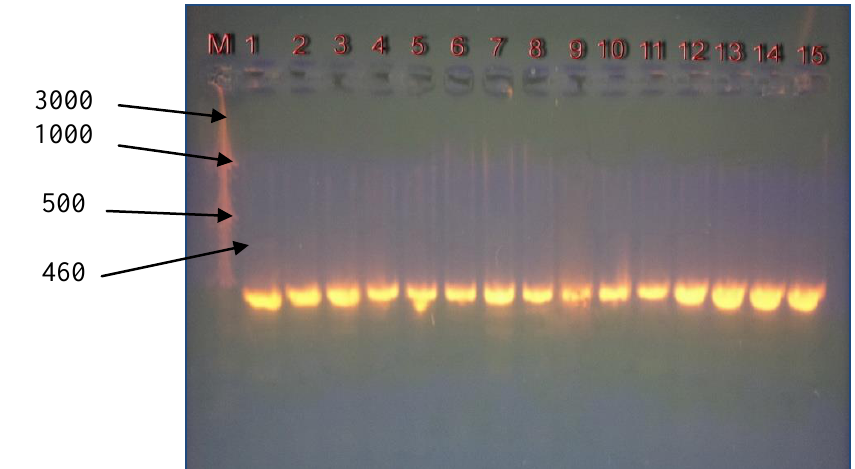
Figure, 2: PCR amplification of Pasteurella multocida DNA using PCR 2% agarose (460 bp) (M) represent DNA ladder(1-15) represent positive samples (460bp).